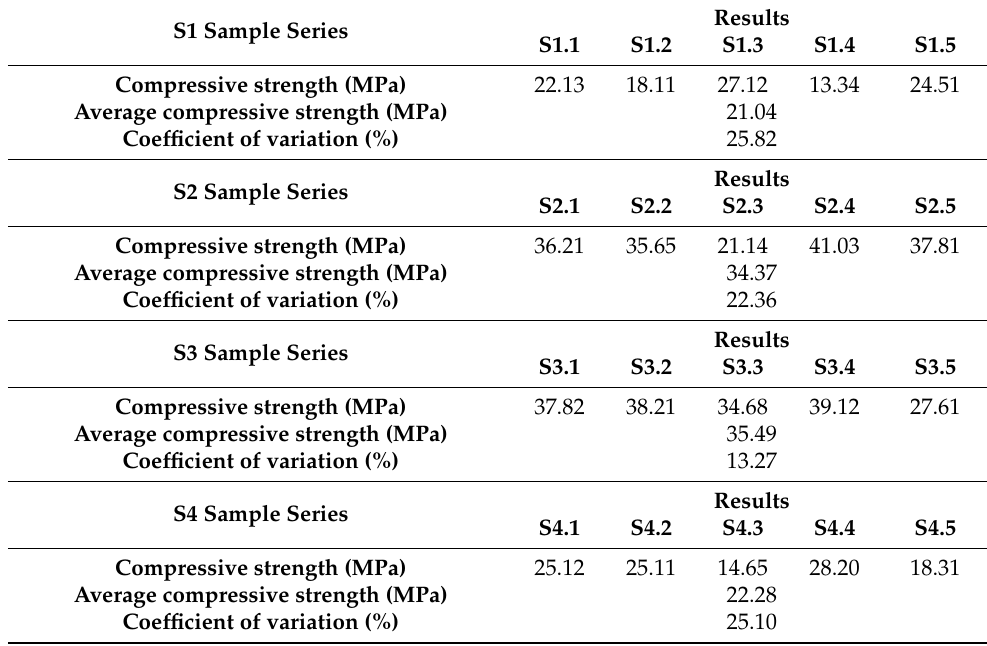
Table 5. Compressive strength.